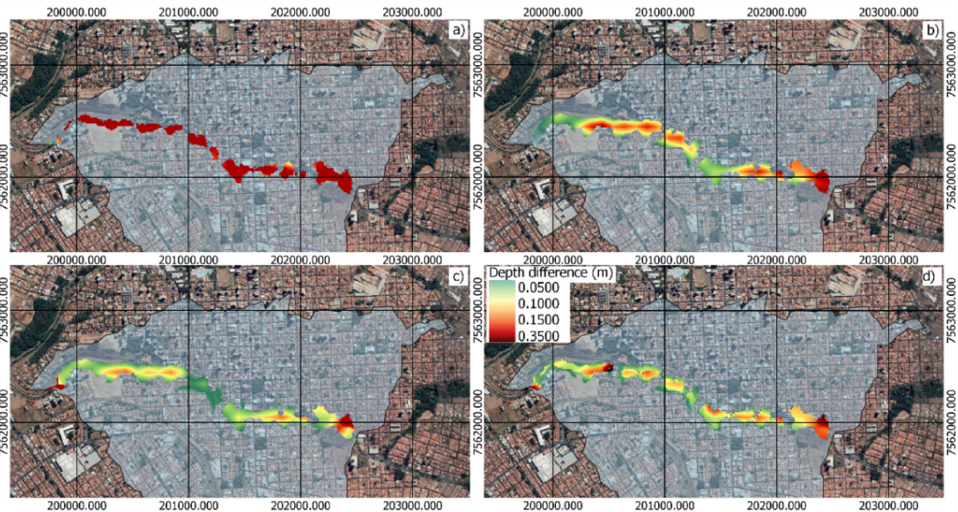
Figure 7. Maximum water depth difference between catchment conditions with and without LID practices for the current climate conditions. Hydrodynamic simulations with: ( a ) a weak rainfall input, ( b ) a moderate rainfall input, ( c ) a strong rainfall input, and ( d ) the average of all rainfall inputs for the current scenario.